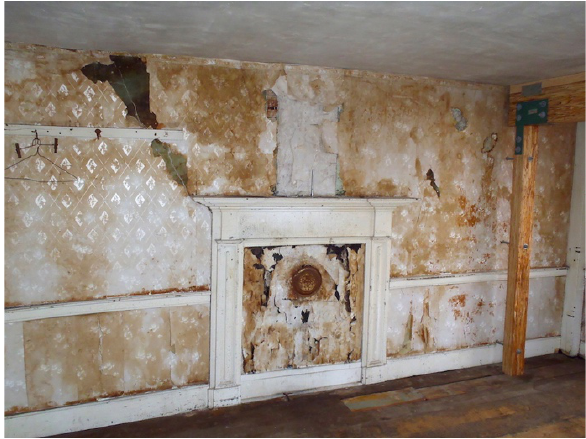
Figure 3: Laser scan of Painted Room east wall by Jost Architects, 2014